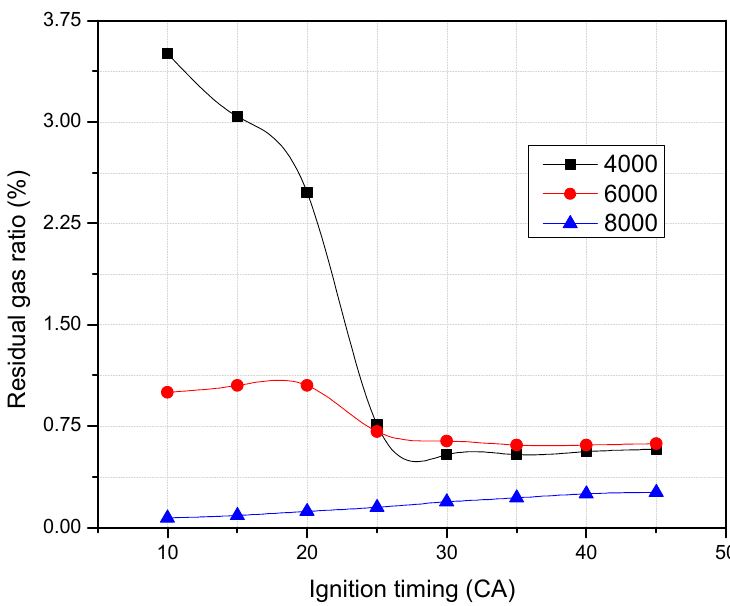
Figure 8. Residual gas ratio versus ignition timing.